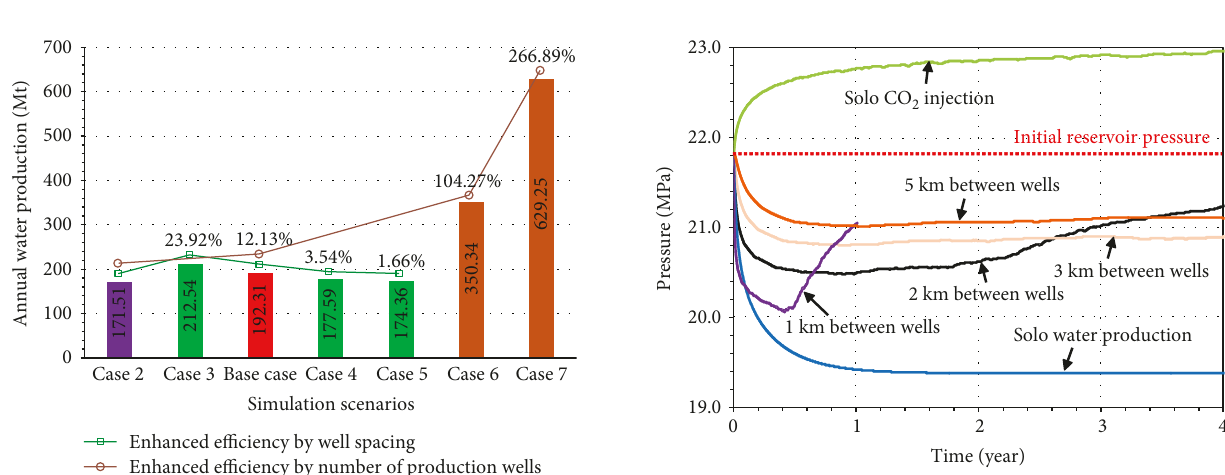
Figure 11: In fl uence of the placement of the production wells on the saline water production capacity.